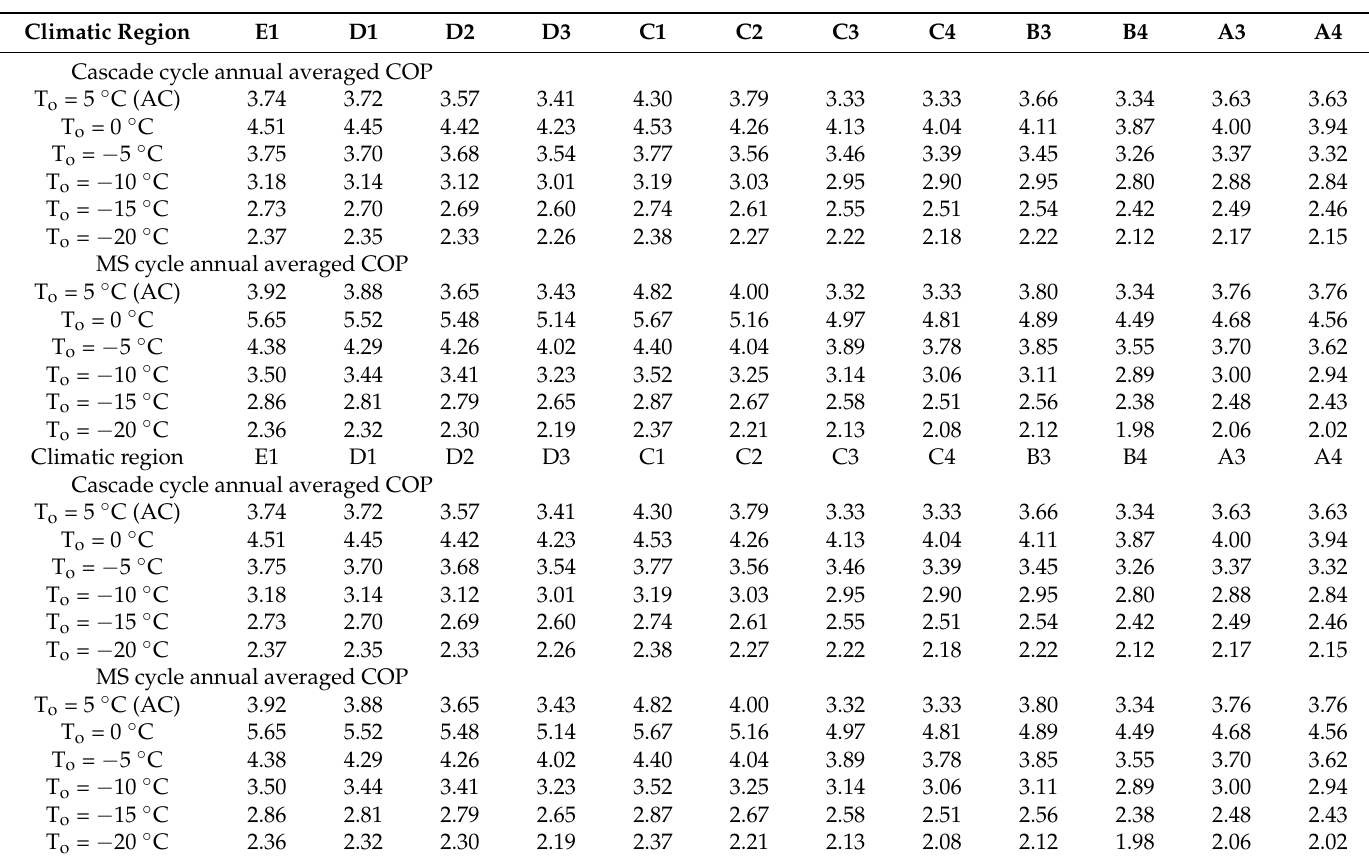
Table 2. Averaged annual COP of cascade and MS cycles for Spanish Climate